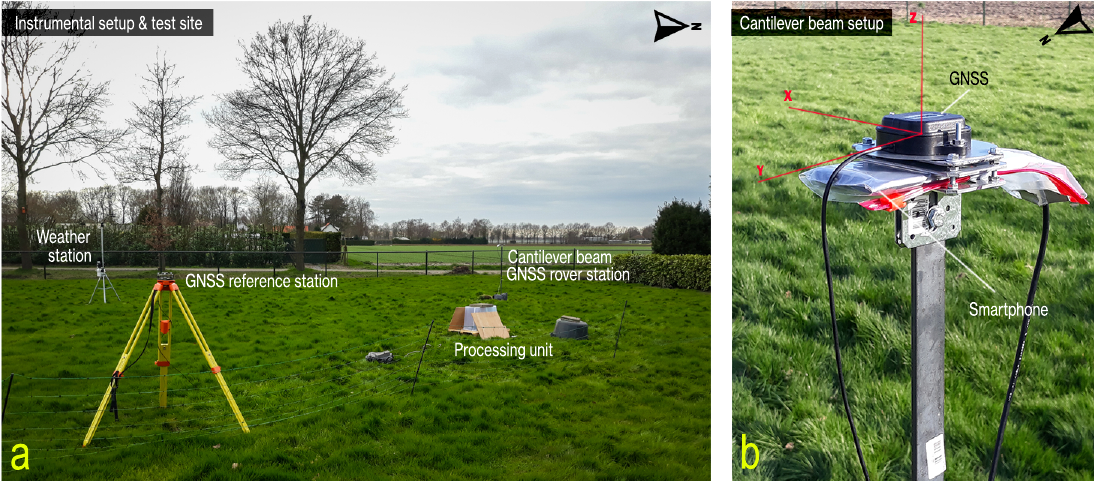
Figure 2. Instrument setup and test site of the ’Cantilever Beam’ experiment: ( a ) Overview of the instrument configuration viewed towards west. ( b ) Rover station sensors alignment at the beam’s top: low-cost GNSS antenna on top with a small metal disc ground plane and smartphone together with plastic cover protection below. The XYZ coordinate system in red coincides with the cardinal East-North-Up (ENU). We will restrict ourselves to the ENU notation in the